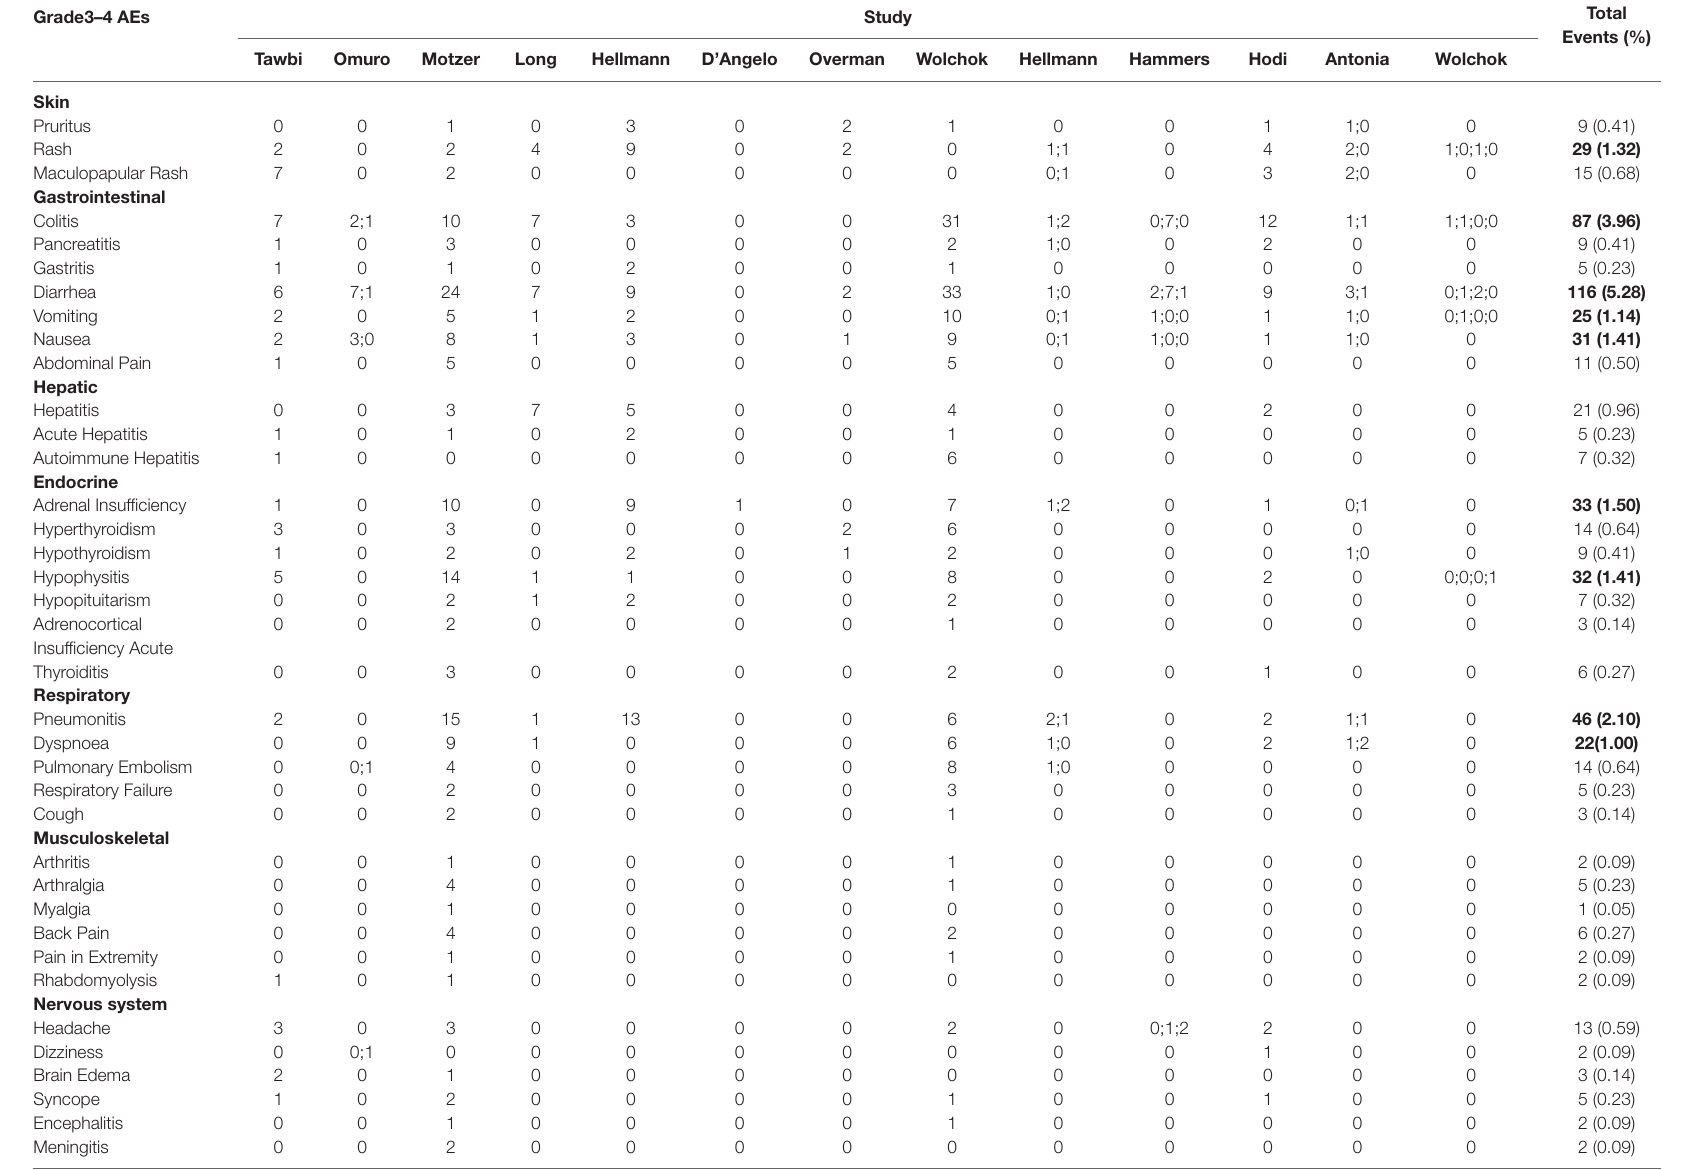
TABLe 3 | Incidence of specific grade 3–4 adverse events in included studies (not included ASCO meeting